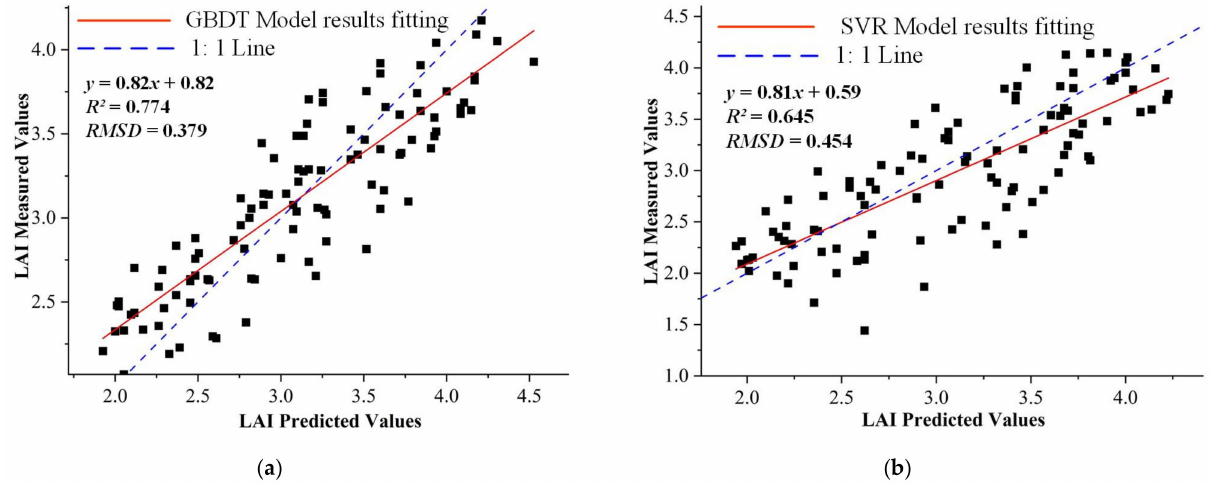
Figure 7. Regression lines between the measured and predicted LAI values for the leaf differentiation stage: ( a ) results of the GBDT model; ( b ) results of the SVR